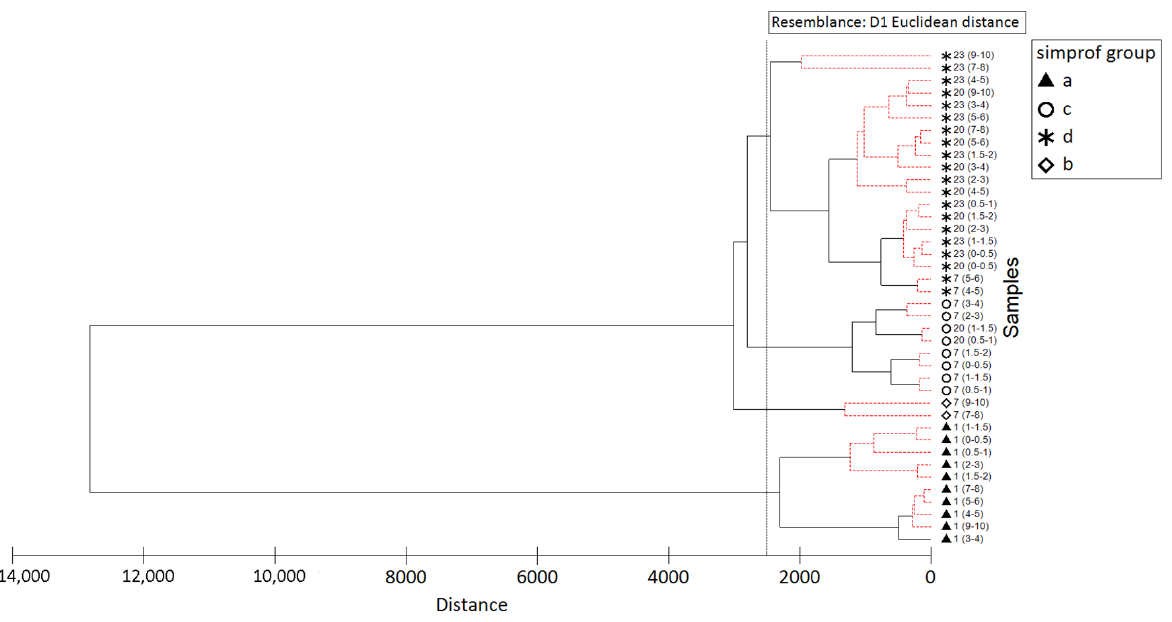
Table 4. Characterization of major sedimentary organic matter variables used for the hierarchical cluster analyses resulting from the SIMPROF analyses; data of foraminiferal biodiversity are in- cluded.